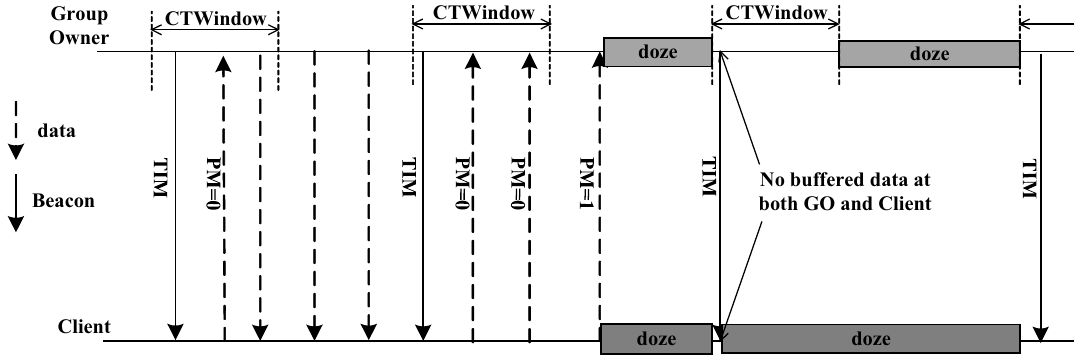
Figure 1. Opportunistic power-saving in Wi-Fi